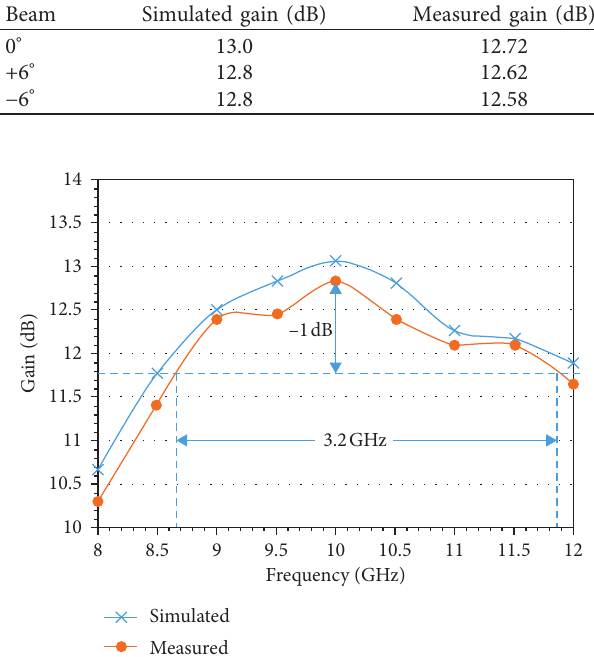
Figure 8: Measured and simulated gain of reflectarrays of 0 ° beam in the X-band frequency